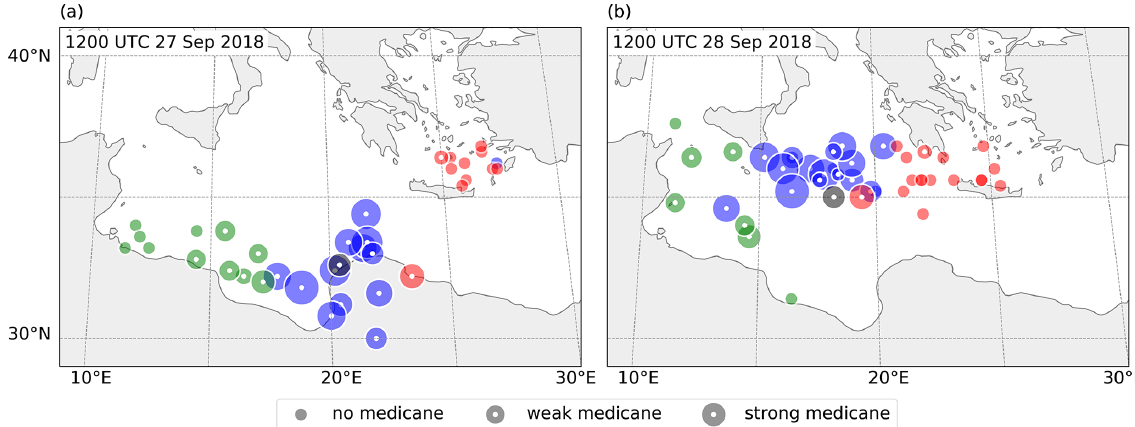
Figure 6. Geographical maps of cyclone positions in all ensemble members and the operational analysis at (a) 12:00UTC 27 September 2018 and (b) 12:00UTC 28 September 2018. For medicanes (markers with white center), the size of the markers is proportional to the maximum intensity of the upper-level warm core (see legend for comparison; no medicane: − V U − V U = 100). Marker colors indicate the cluster to which the cyclone belongs (W: green, C: blue, E: red, analysis: black; discussed in T Sect.